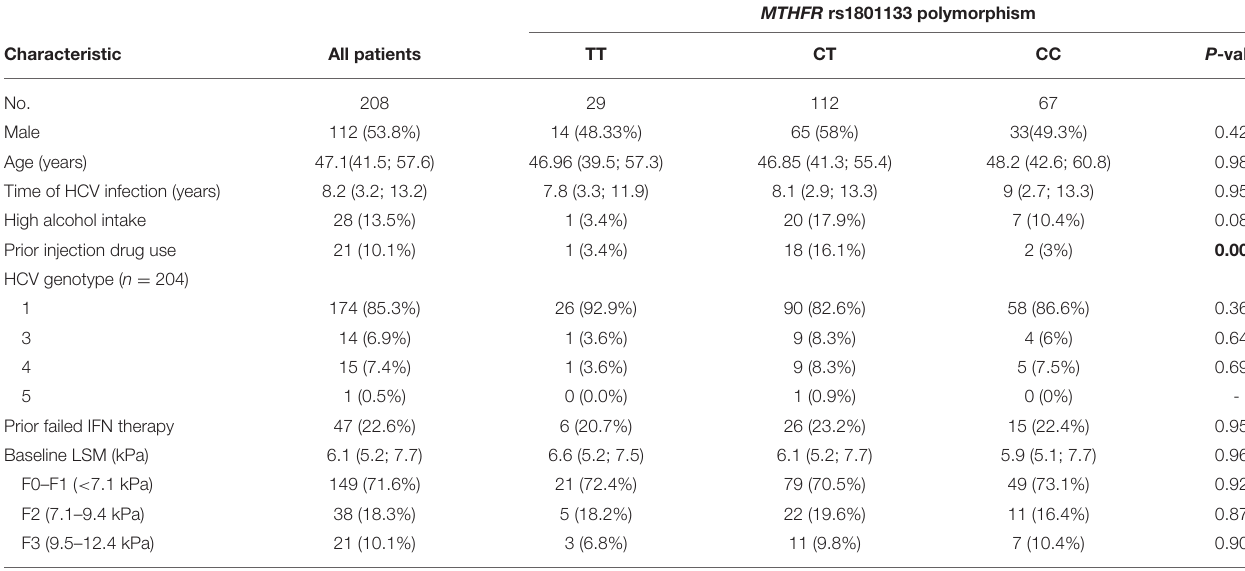
MTHFR rs1801133